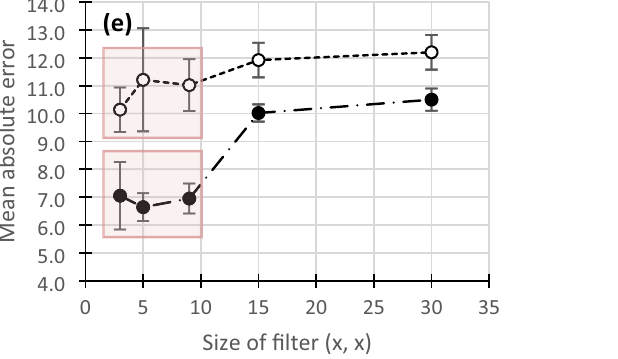
Figure 2. Impact of CNN structure and depth on MAE of test set predictions. ( a ) Varies the number of convolutional layers without any max pooling layers, ( b ) varies the number of layer sets with 1 convolutional layer followed by max pooling, ( c ) varies the number of convolutional layers between max pooling layers (4 max pooling layers in total), ( d ) varies the number of convolutional filters for 1 convolutional layer without max pooling, ( e ) varies the size of the receptive field for 1 convolutional layer without max pooling. Red boxes delineate areas of optimal performance, where all models within the box performed similarly based on t tests at 95% confidence